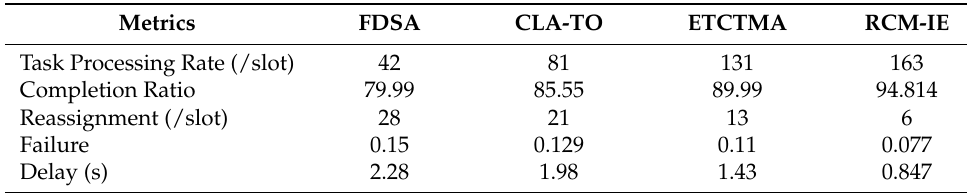
Table 2. Comparative analysis summary